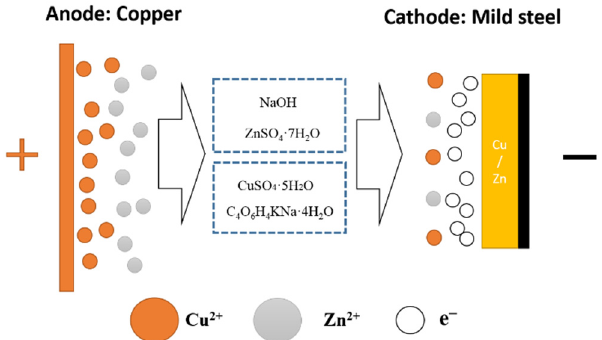
Figure 4. The free Cu 2+ and Zn 2+ in the solution form a complex with NaOH and C 4 O 6 H 4 KNa, result- ing in fewer metal cations discharging at the cathode and increasing cathodic